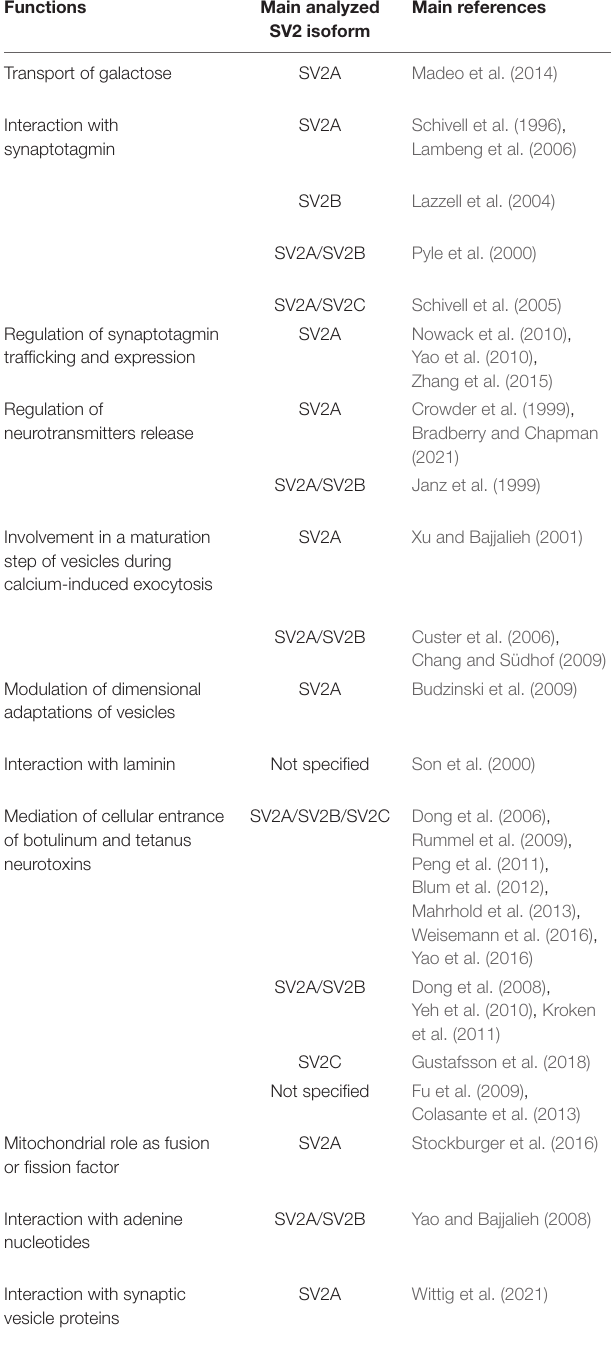
TABLE 1 | Possible functions of synaptic vesicle glycoproteins 2 (SV2).